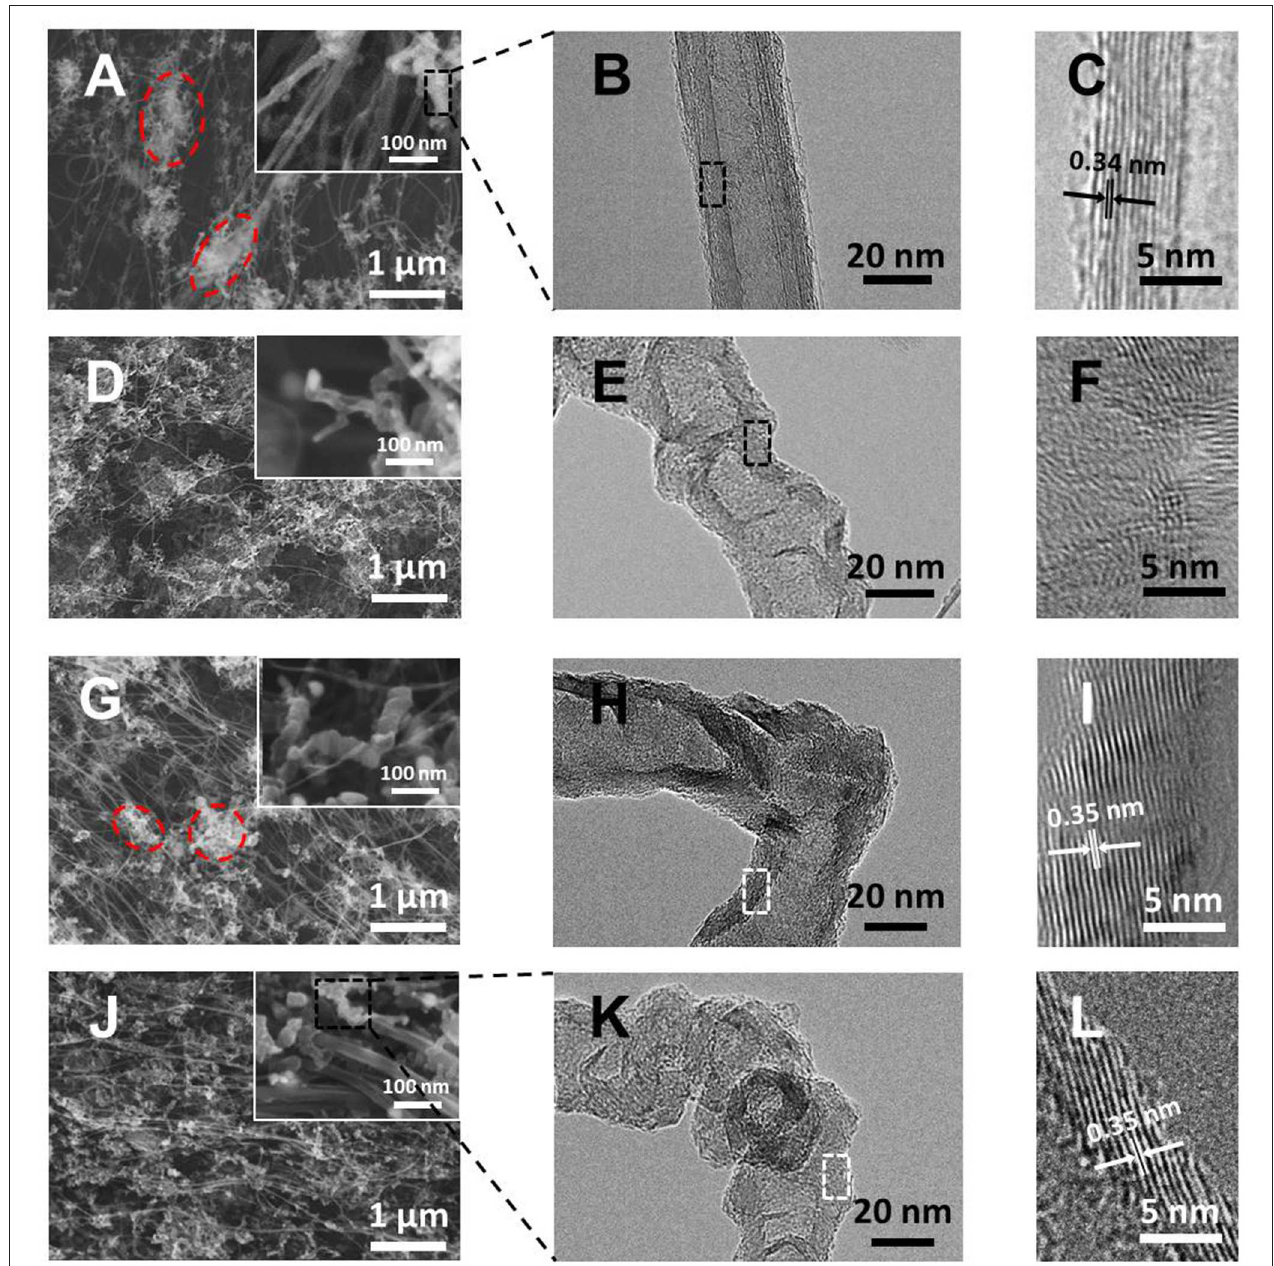
FIGURE 2 | (A,D,G,J) SEM images of CNTs, py-CNTs, B-CNTs, and py-B-CNTs films at different magnifications; (B,E,H,K) TEM images; and (C,F,I,L) high-resolution TEM images of CNTs, py-CNTs, B-CNTs, and py-B-CNTs films, respectively.